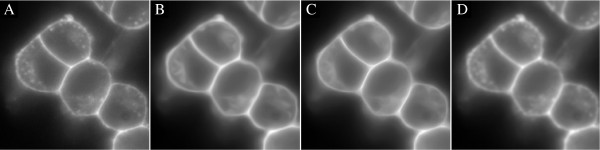
Smoothing of PC12 cells in 2D by Example 3. A) Raw surface stain, B) smoothing by coherence enhancing diffusion (method = ’ced’), C) directional coherence enhancing diffusion (method = ’dirced’), and D) Gaussian smoothing (method = ’gaussian’). The sharpness is better preserved by the anisotropic filters (B and C), which makes them more suitable for the enhancement of surface stained cells.